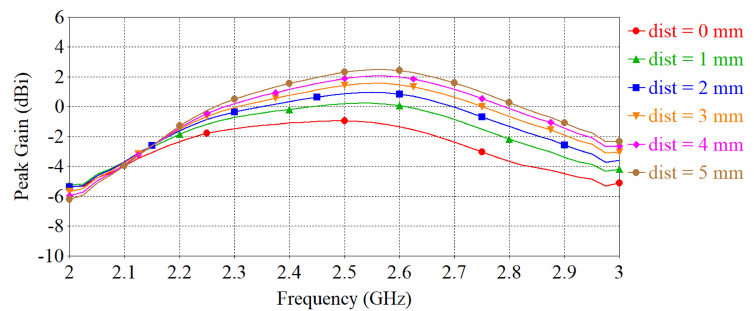
Figure 15. Peak gain vs. frequency when varying the separation between the antenna and phantom.